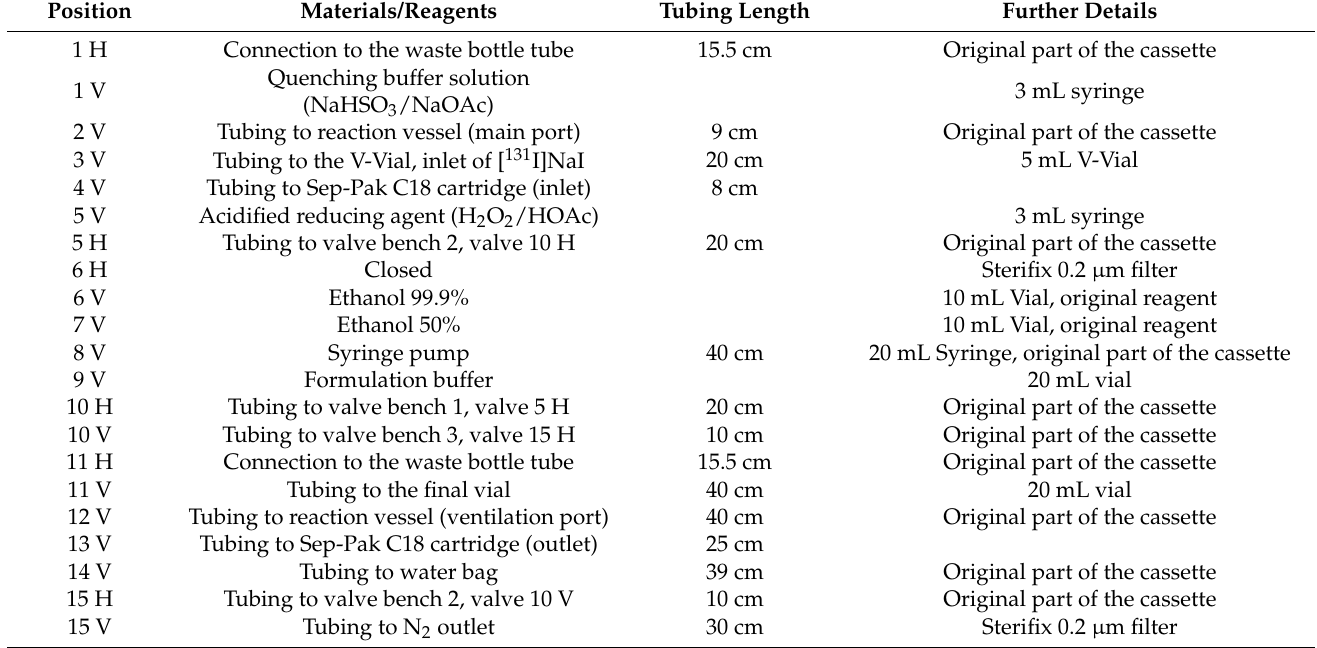
Table 3. Assembly list for the Scintomics GRP module. H = Horizontal port, V = Vertical